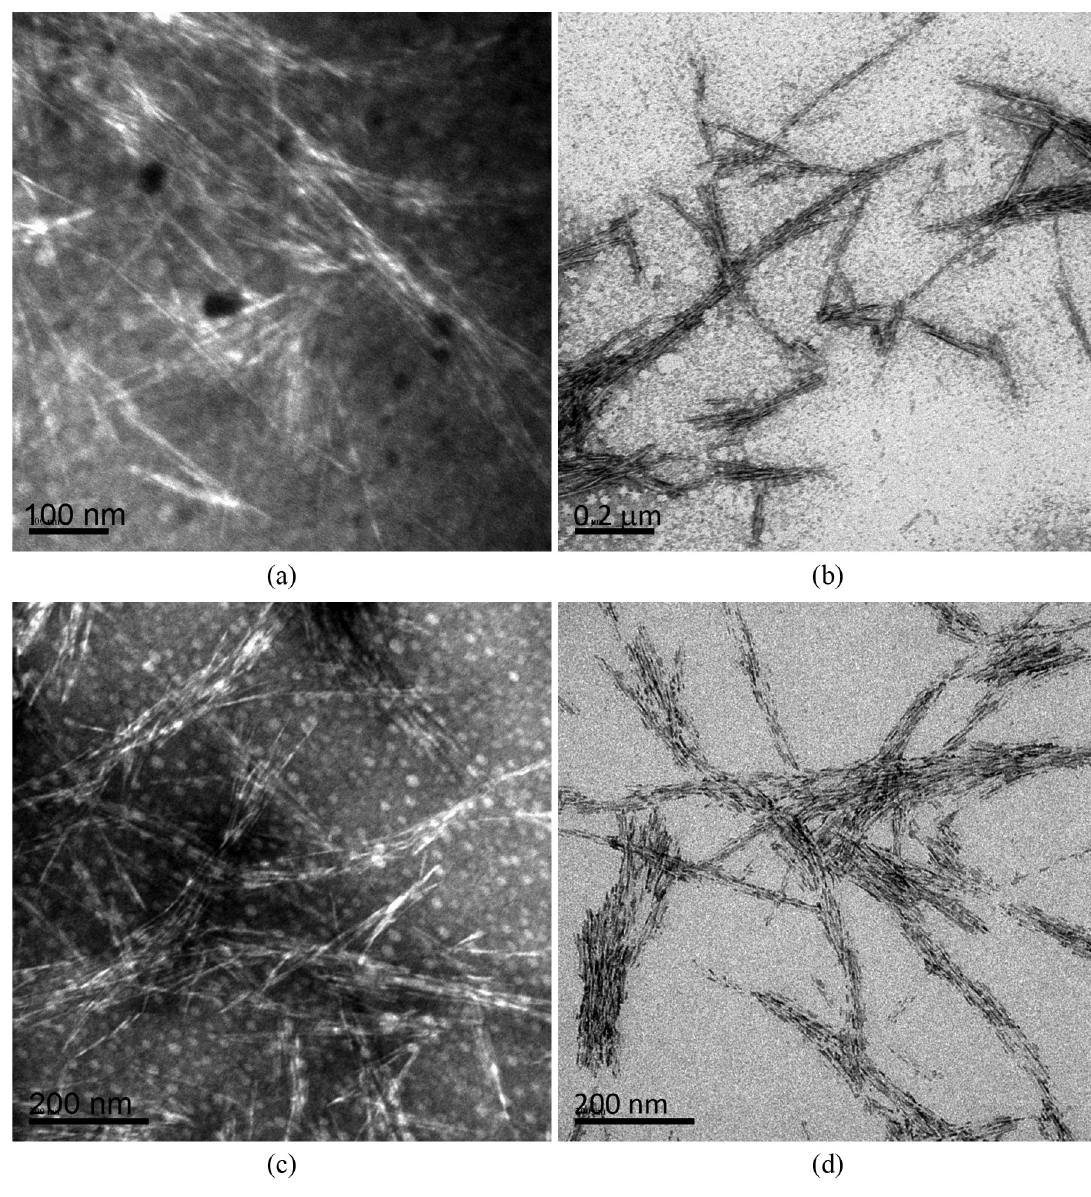
Figure 4. Transmission electron microscopy of all samples